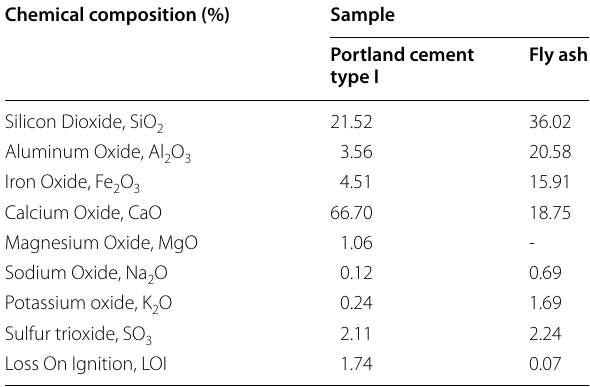
Table 1 Chemical compositions of Portland cement type I and fly ash.